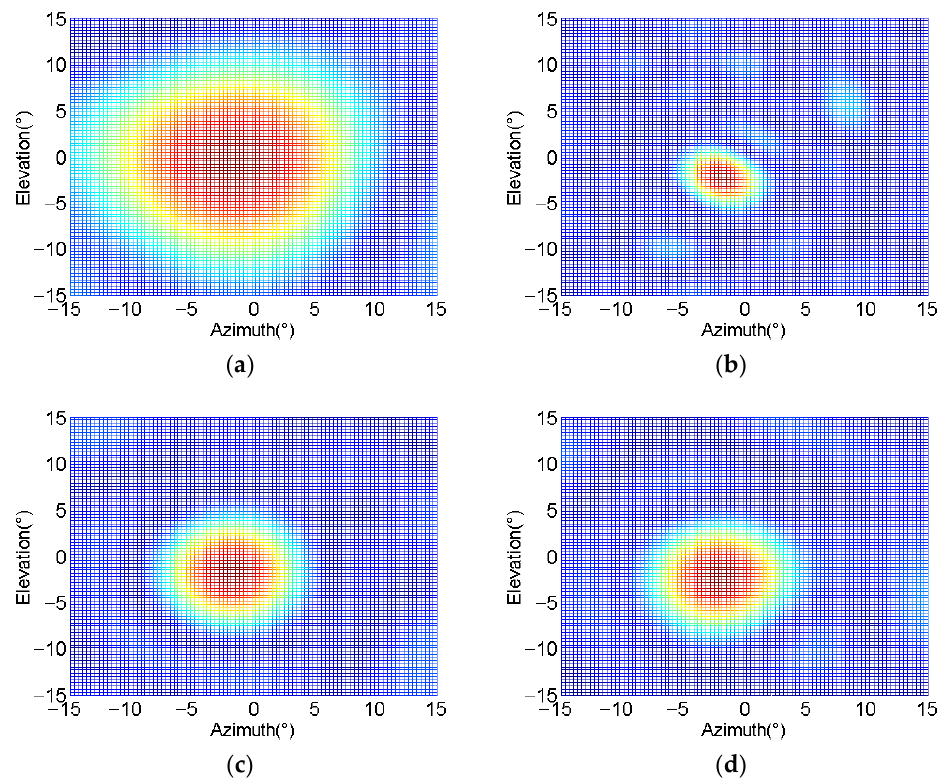
Figure 27. Positioning experiment. ( a ) Minimum operating distance; ( b ) Maximum operating distance; ( c ) 23 m operating distance; ( d ) 23 m operating distance.